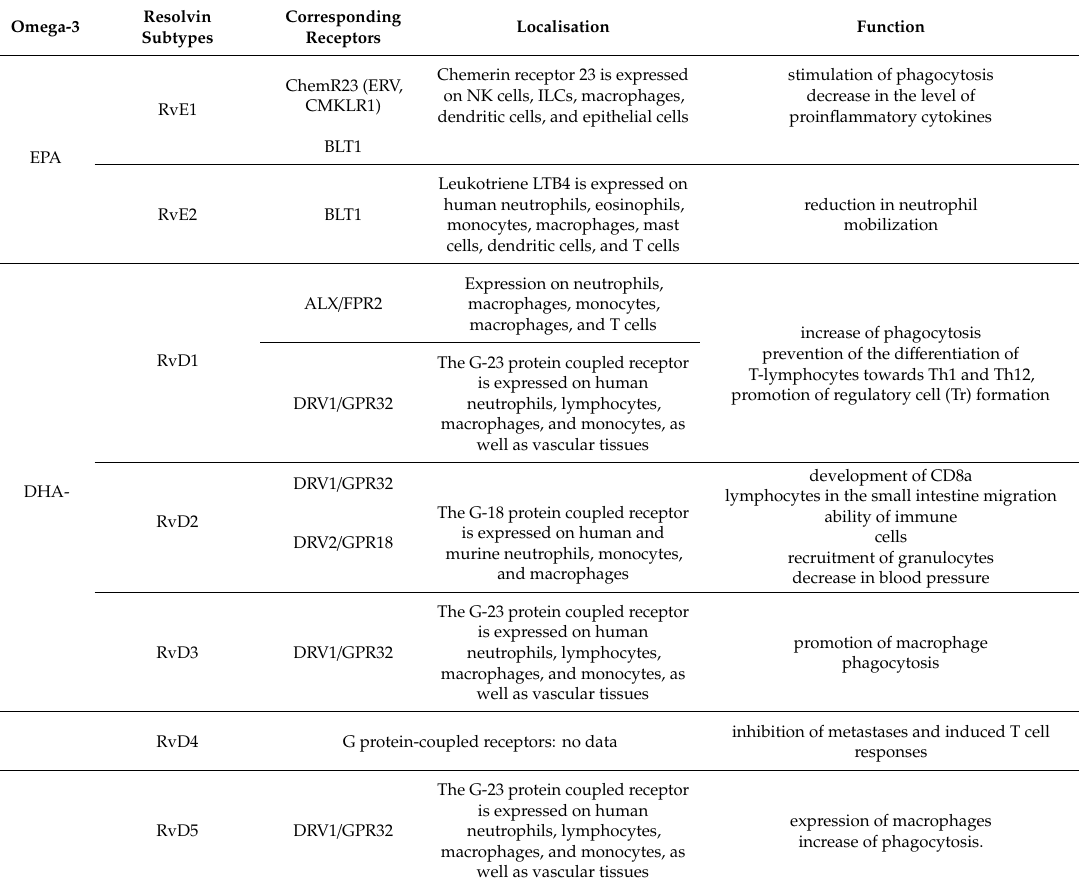
Table 1. Characterization of resolvin subtypes and their